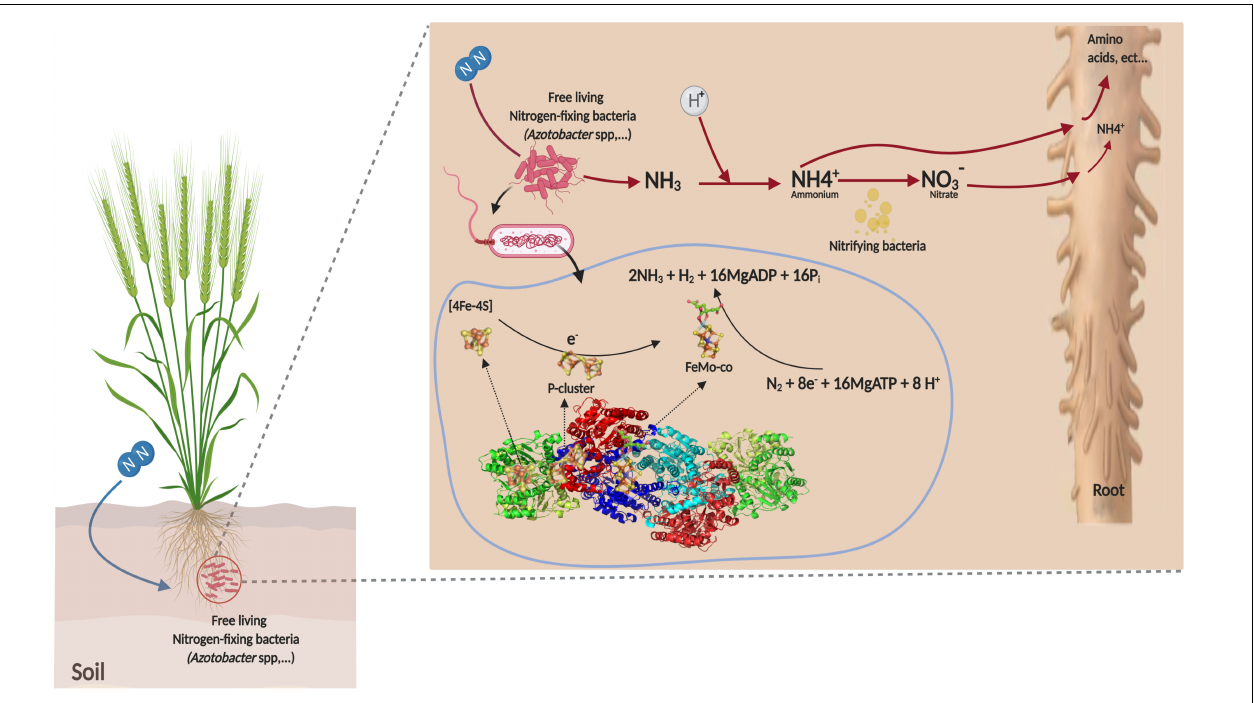
FIGURE 3 | Mechanism of non-symbiotic fixation of atmospheric nitrogen by Azotobacter